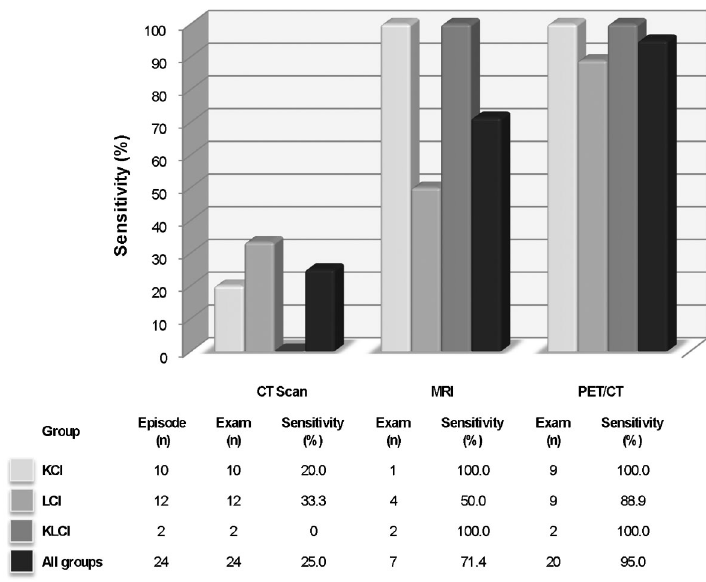
Figure 3. Sensitivity of different imaging methods to detect cyst infection in autosomal dominant polycystic kidney disease/autosomal dominant polycystic liver disease. CT: computed tomogra- phy; MRI: magnetic resonance imaging; PET: positron-emission tomography; KCI: kidney cyst